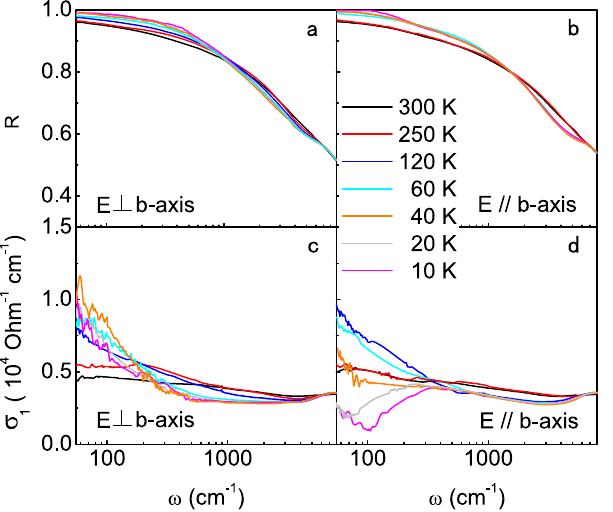
Figure 3. Polarized optical reflectivity and conductivity of MnP. ( a , b ) Temperature dependence of the reflectivity spectra R ( ω ) for E ⊥ b and b E ; ( c , d ) Temperature dependence of the real part of the optical conductivity σ 1 ( ω ) for E ⊥ b and b E .